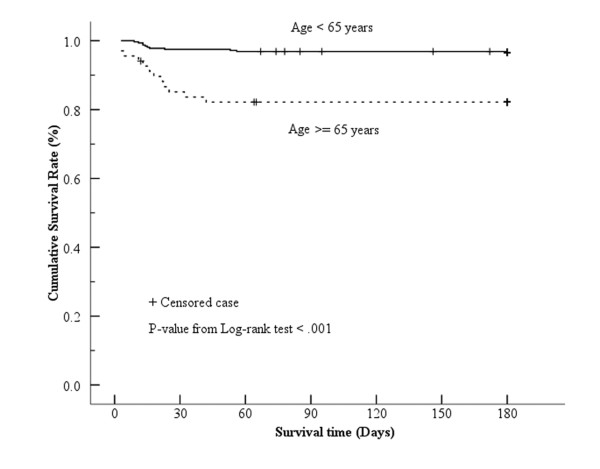
Log-rank test Kaplan-Meier survival curves for elderly and non-elderly adults following caustic ingestion.